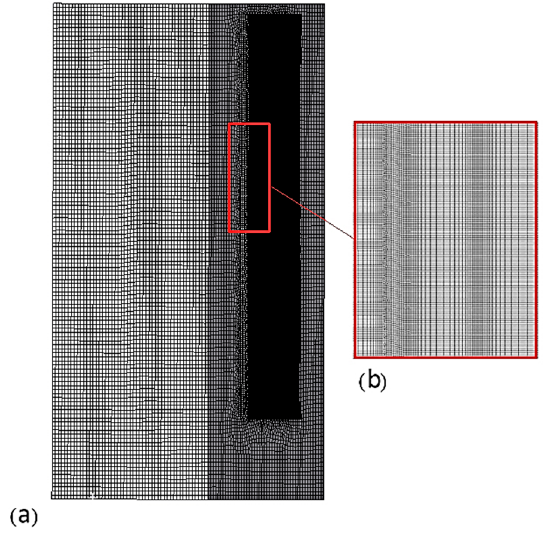
Figure 4. ( a ) Grid generation in the indoor space. ( b ) Vertical cross section of the cavity.